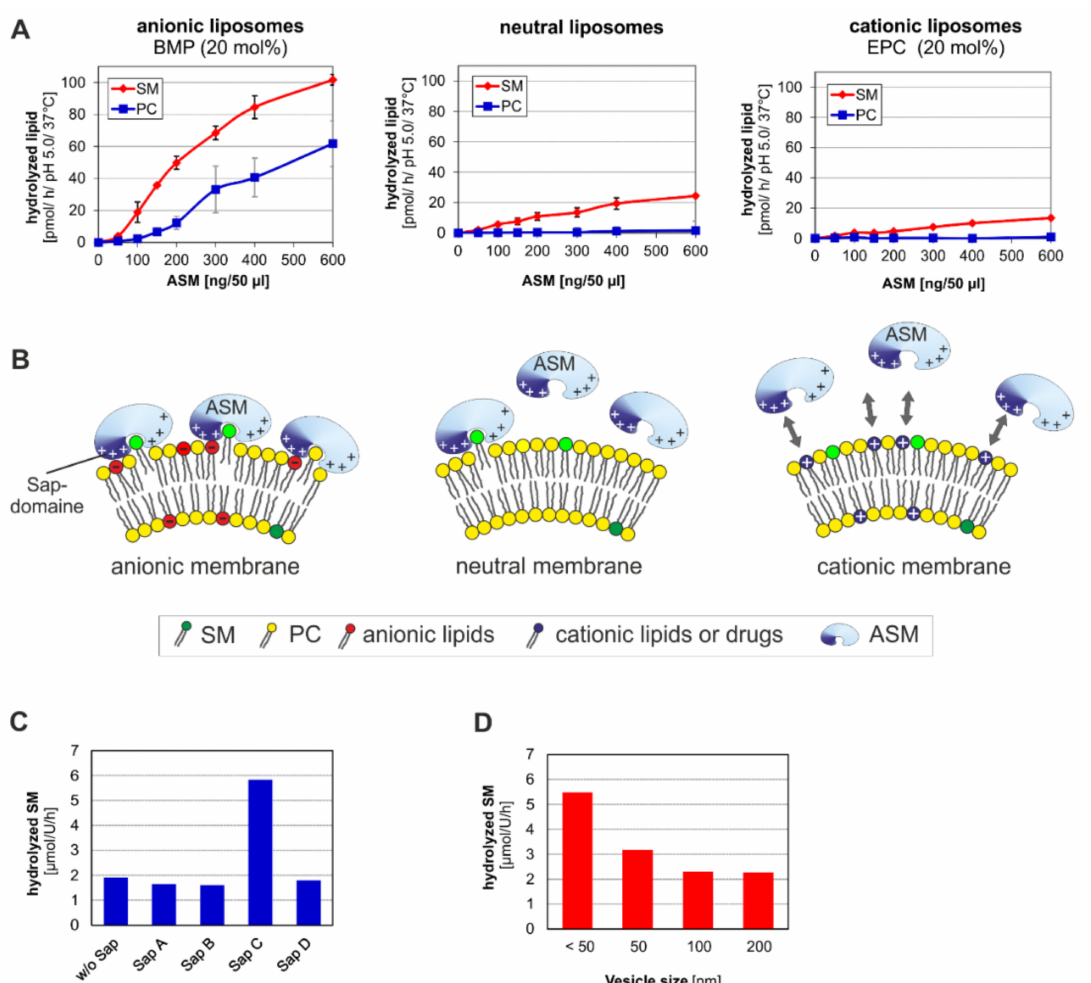
Figure 3. ( A ) ASM activity on membrane embedded sphingomyelin and phospholipids (e.g., phosphatidylcholine) is stimu- lated by anionic lipids (e.g., BMP) and inhibited by cationic substances (e.g., 1,2-dioleoyl- sn -glycero-3-ethylphosphocholine (EPC)) [48]. ( B , left ) The cartoon shows a strong electrostatic binding of cationic ASM to a negatively charged (anionic BMP containing) membrane surface, supporting an ASM mediated hydrolysis of membrane embedded sphingomyelin and other ASM-substrates. ( B , middle ) shows a decreasing electrostatic attraction, a reduced binding or loose attachment of cationic ASM to a neutral membrane surface reducing the catabolism of sphingomyelin and other phospholipids. ( B , right ) visualizes a strong electrostatic repulsion between cationic ASM and a positively charged membrane surface containing cationic lipids (EPC), effectively reducing the hydrolysis of membrane embedded SM and other phospholipids by a released ASM, which furthermore may become an easy prey of proteolytic digestion in a lysosomal environment [28]. ( B ) was modified after [48]. ( C ) External Sap C treatment and ( D ) a small vesicle size of negatively charged liposomes stimulates sph- ingomyelin degradation best. Data are taken from the following publications: ( A ) [48], ( C , D ) [42]. ASM: acid sphingomyeli- nase, BMP: bis(monoacylglycero)phosphate, EPC: 1,2-dioleoyl- sn -glycero-3-ethylphosphocholine, PC: phosphatidylcholine, SM: sphingomyelin.